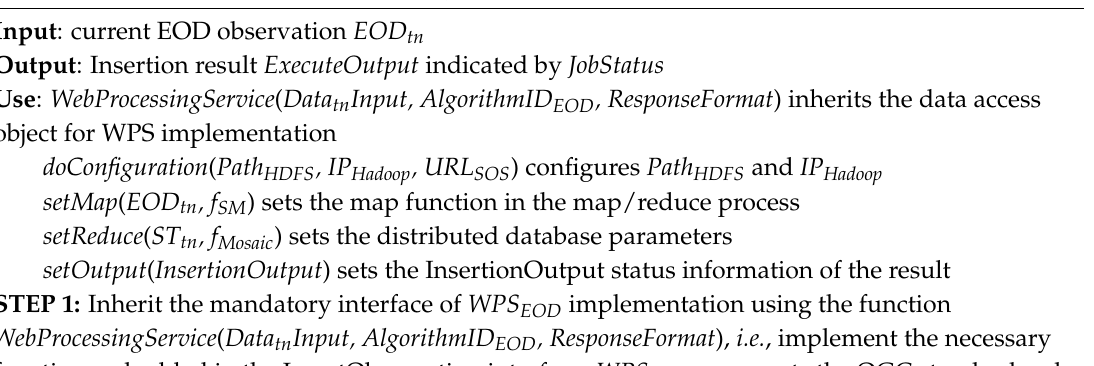
Algorithm 1 : Flow of the map/reduce algorithm for mapping